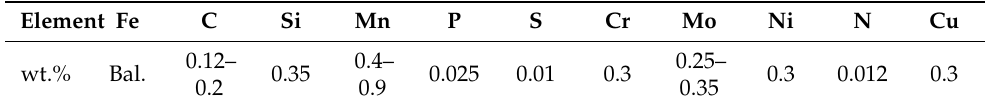
Table 1. Chemical composition of 16Mo3 steel.